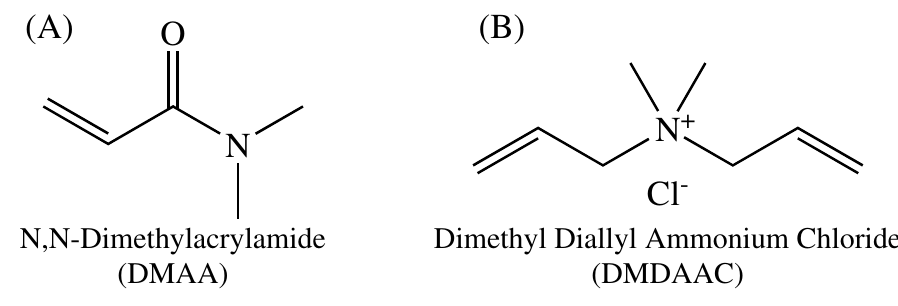
Figure 5. Molecular structures of ( A ) DMAA and ( B ) DMDAAC.